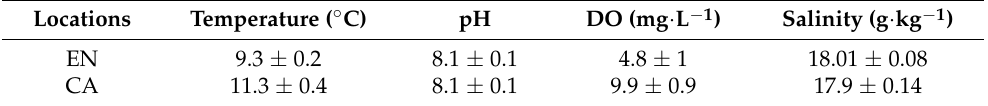
Table 1. Physicochemical parameters of the Black Sea water from EN and CA areas.